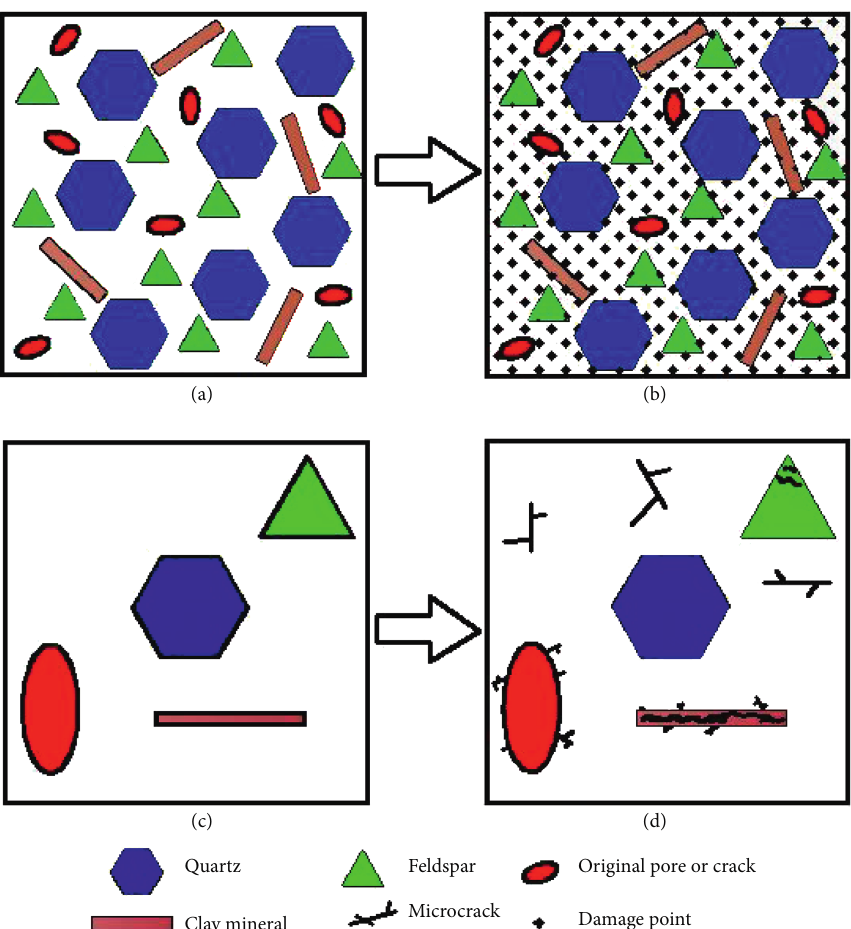
Figure 14: Microscopic process of a water-rock dry-wet cycle. (a) Original structure of feldspar sandstone. (b) Damage structure of feldspar sandstone. (c) Original unit structure. (d) Damage unit